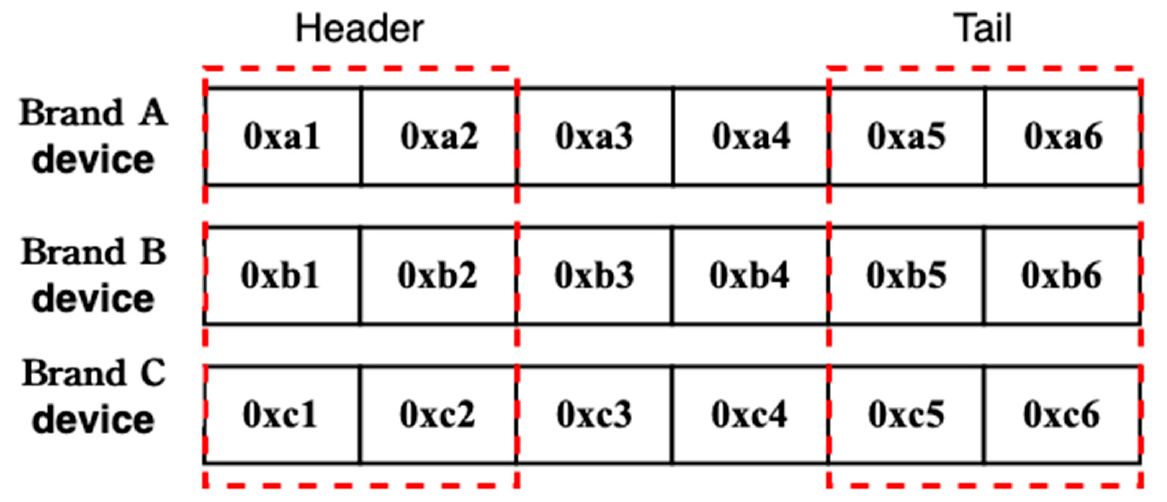
Figure 5. Schematic diagram of packet information.